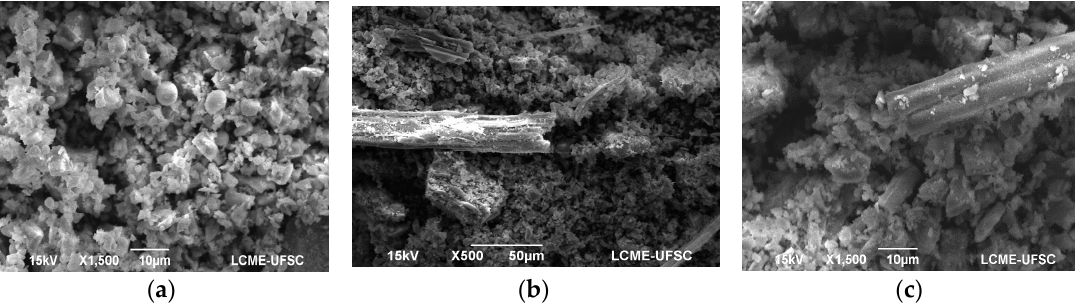
Figure 3. Singular electron microscope (SEM) images: ( a ) Bottom ash after grinding and calcination at